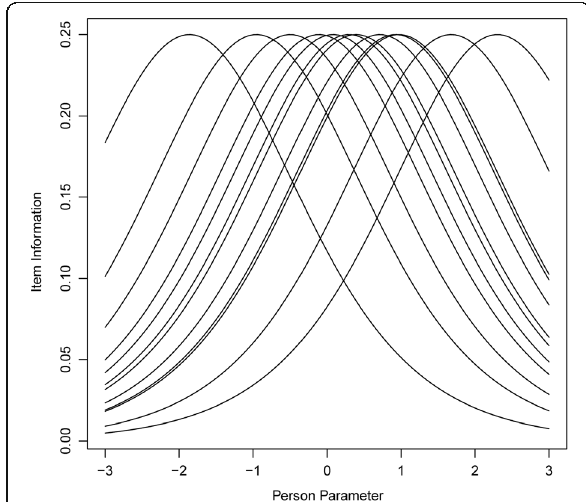
Fig. 5 Item information curves for all items of the bMCU test as a function of the person parameters of the N = 249 students. Item information curves display the information provided by each item ( y -axis) at each level of person ability ( x -axis). Higher information corresponds to higher precision. The precision of the test at a certain level of person ability results from adding the information of each item at this level of person